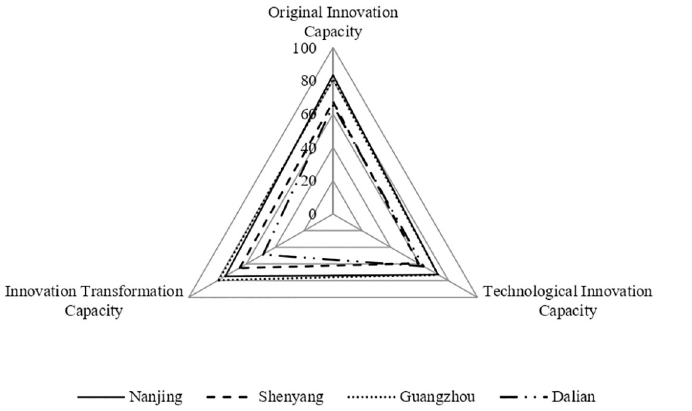
Fig 5. Three capacities of UICs in cities with medium innovation